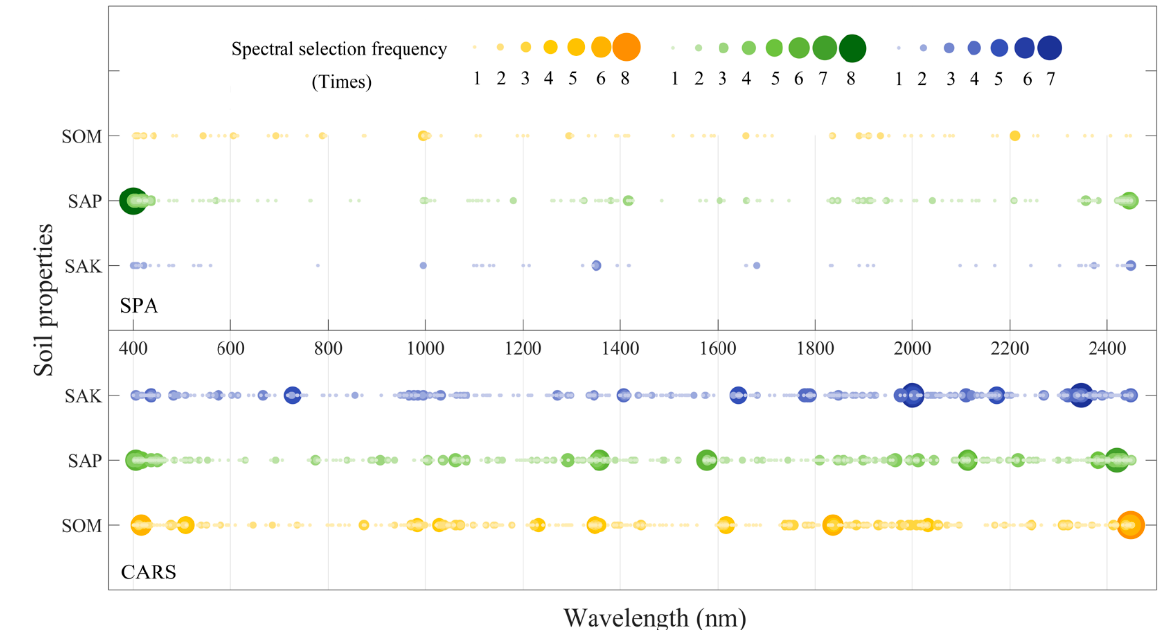
Figure 5. Concentrated map of selected wavelengths of the different spectral variable selection methods (the horizontal axis represents the wavelength from 400 nm to 2450 nm, the vertical axis represents the three soil nutrients, the different size indicates the numbers of times each wavelength was selected by the 14 spectral forms).